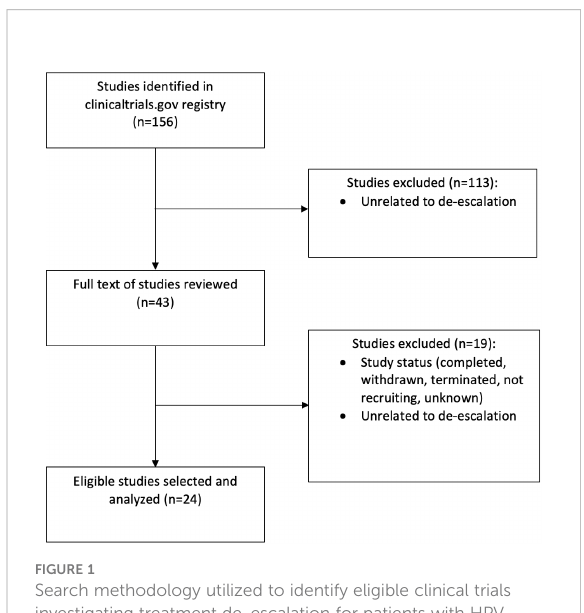
FIGURE 1 Search methodology utilized to identify eligible clinical trials investigating treatment de-escalation for patients with HPV- associated oropharyngeal cancer.